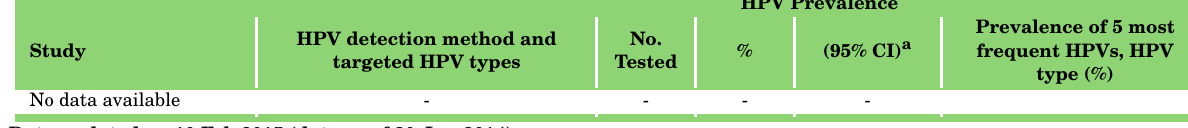
Table 32: Studies on HPV prevalence among PeIN 2/3 cases in